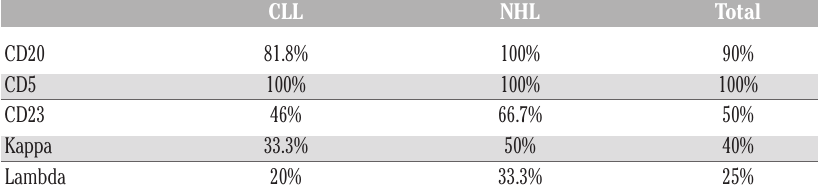
Table 4. Sensitivity of immunohistochemistry markers in chronic lymphocytic leukemia and non Hodgkin lymphoma groups. CLL NHL